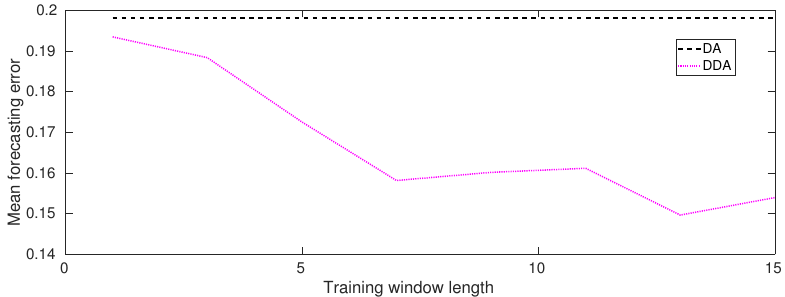
Figure 8. Mean forecasting error-second test case.